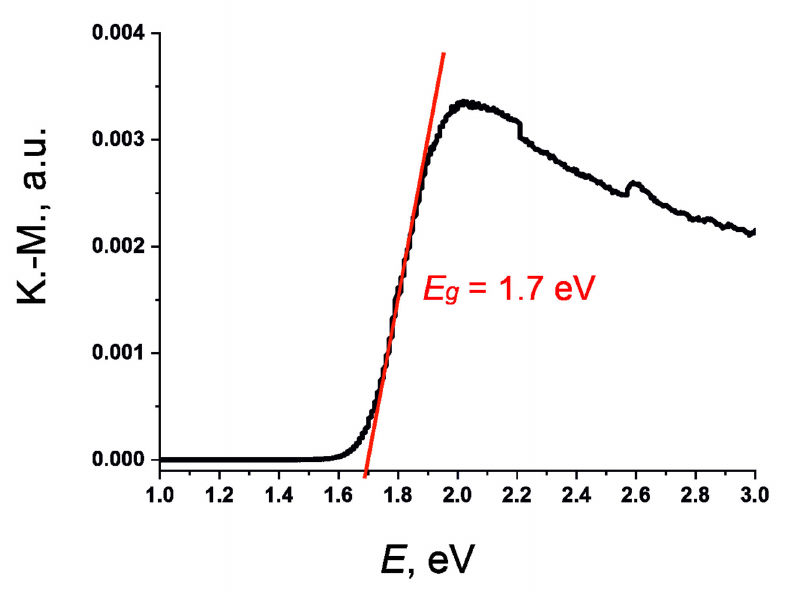
Figure 7. Kubelka–Munk plot for compound 4